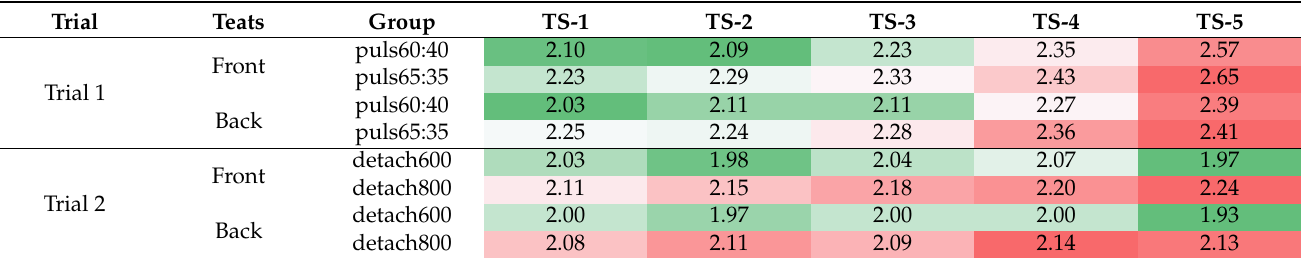
Table 5. Teat scores of cows (TS-1 to TS-5) in chronological order, distinguished between front and back teats for Trial 1 and Trial 2. Cells background is colored with green for the low TS values and it becomes red when the TS values worsen (higher TS values).